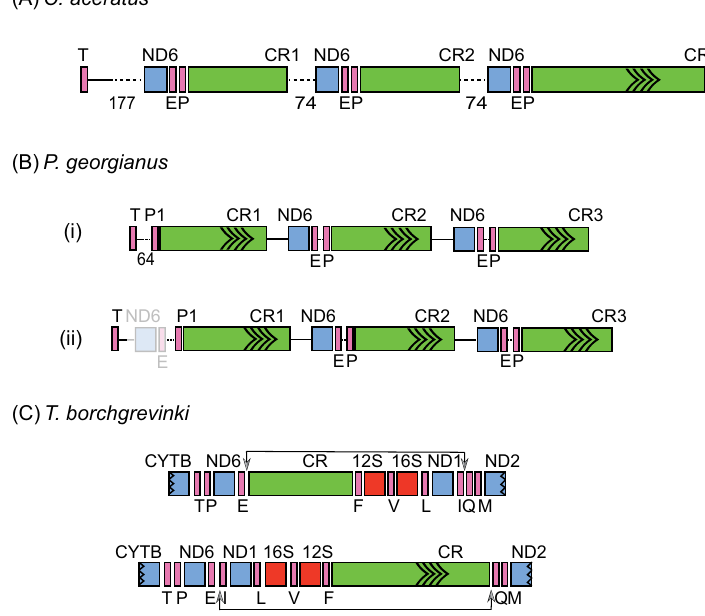
Figure 3. Duplication topology. ( A ) Region showing the tandem duplicated block for C. aceratus with repeats in CR3. ( B ) (i) Region containing the tandem duplicated block for P. georgianus and all the control regions with repeats. (ii) The light colored region between T and P shows the potential copy of ND6 and E that might have been lost. The dotted region between E and P1 matches the region between E and P in retained copies thus showing the presence of third copy of the ND6 / trnE / trnP /CR block which is partially lost. ( C ) Comparison of the reference (top) versus our mt genome of T. borchgrevinki (bottom). The arrows on top show the position of the region which is inverted in our assembled genome. The arrows in the CR are the tandem